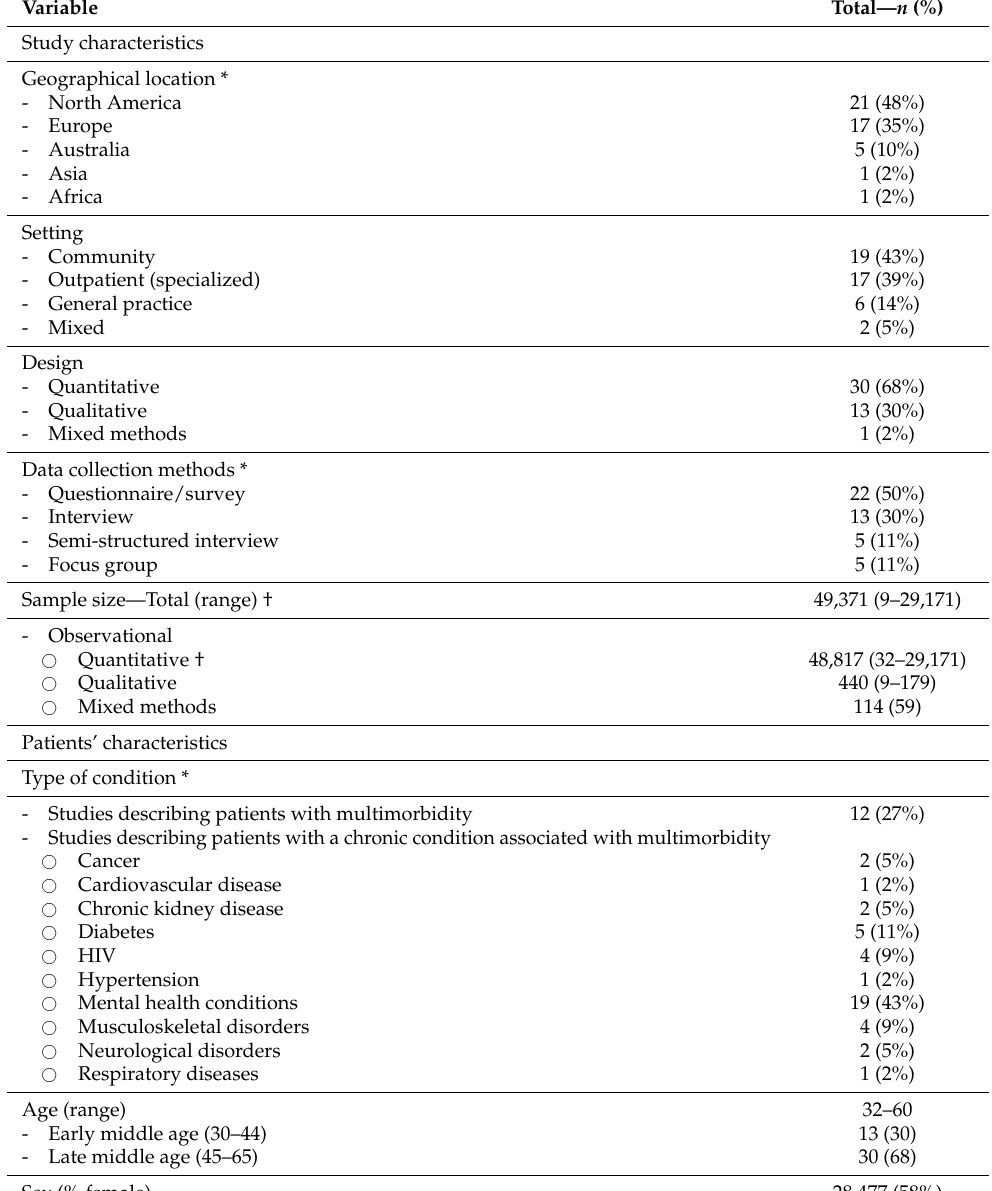
Table 2. Descriptive summary of included